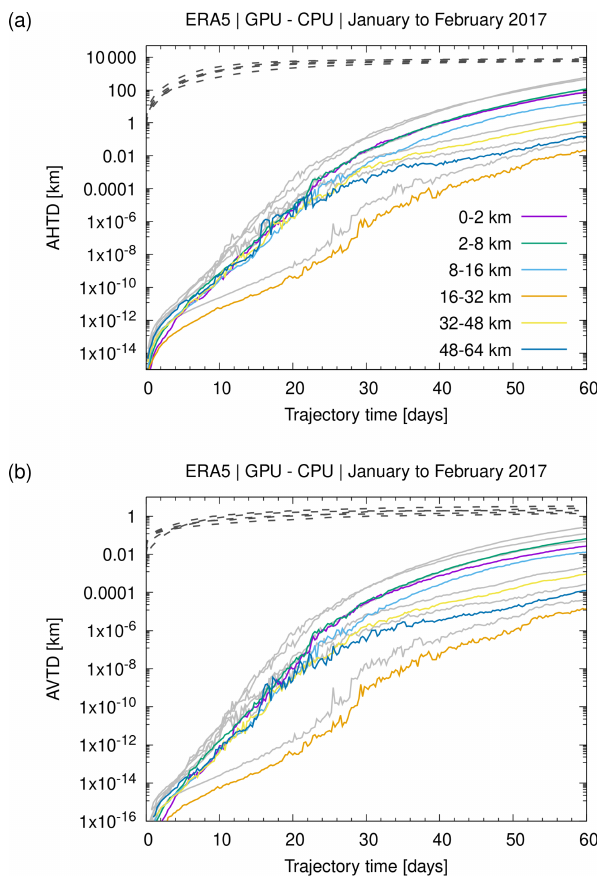
Figure 6. Absolute (a) horizontal and (b) vertical transport devia- tions (AHTDs and AVTDs) between kinematic trajectories calcu- lated with the CPU and GPU code of MPTRAC as compiled with the PGI C compiler (colored curves). Simulations start on 1 Jan- uary 2017, 00:00UTC and comprise 60d of simulation time. For this test case, 10 6 trajectory seeds were globally distributed in dif- ferent height ranges between the lower troposphere and the meso- sphere (see plot key). Transport deviations between simulations us- ing the CPU code compiled with the GNU and PGI C compilers are shown for comparison (light gray, solid curves). Transport devia- tions due to subgrid-scale wind fluctuations and diffusion are also shown for reference (dark gray, dashed